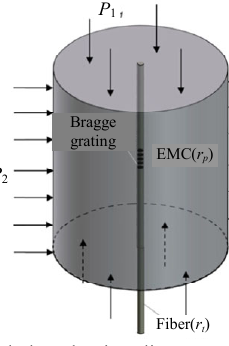
Fig. 11 Embedded packaging diagram.